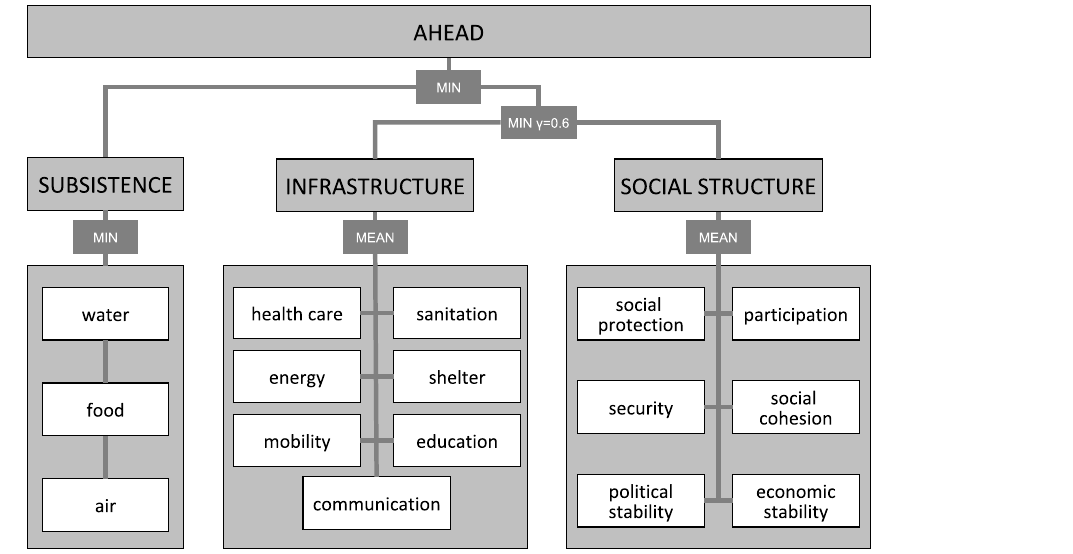
Figure 1. Overview of the fuzzy aggregation tree to calculate AHEAD. Detailed explanations of each variable, as well as the aggregation procedures, are given in Sects 2.2 and